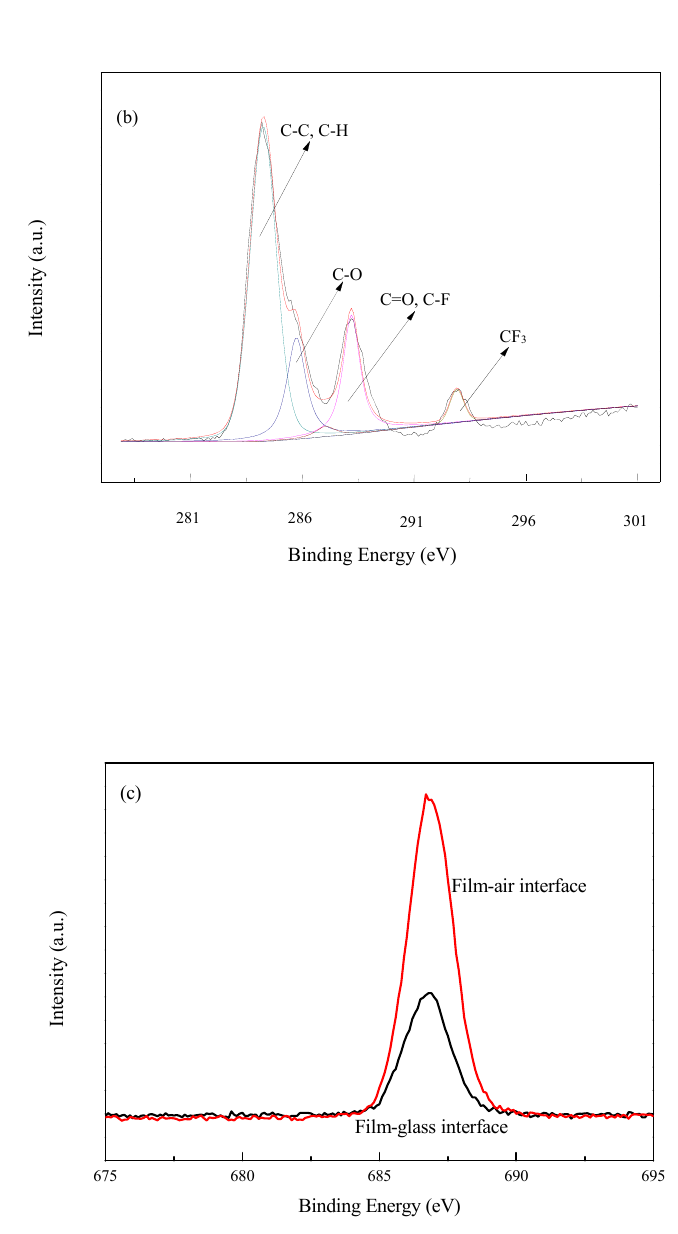
Figure 5. XPS spectra of Si/F polyacrylate emulsion film: ( a ) the films–glass interface, ( b ) High-resolution of C1s signal, and ( c ) F1s signal for film–air interface and film–glass interface.